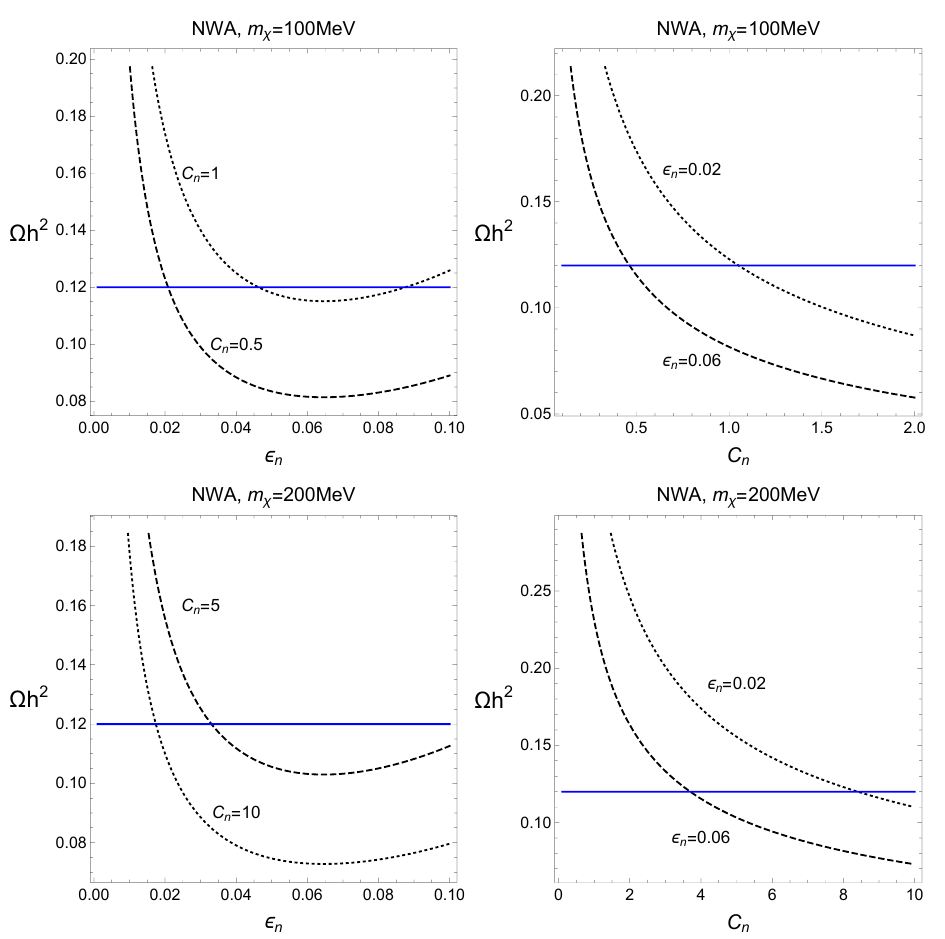
Figure 5 . Relic density as a function of (cid:15) n ( C n ) in the s -wave models in the left (right) panels. Blue solid line corresponds to the central value of the relic density by Planck. The results are shown in the narrow width